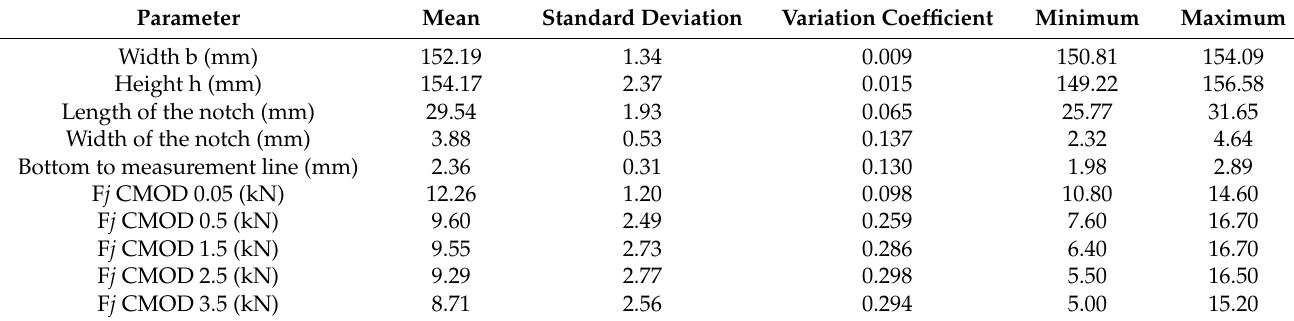
Table 4. Results of the statistical analysis for concrete with steel fibre